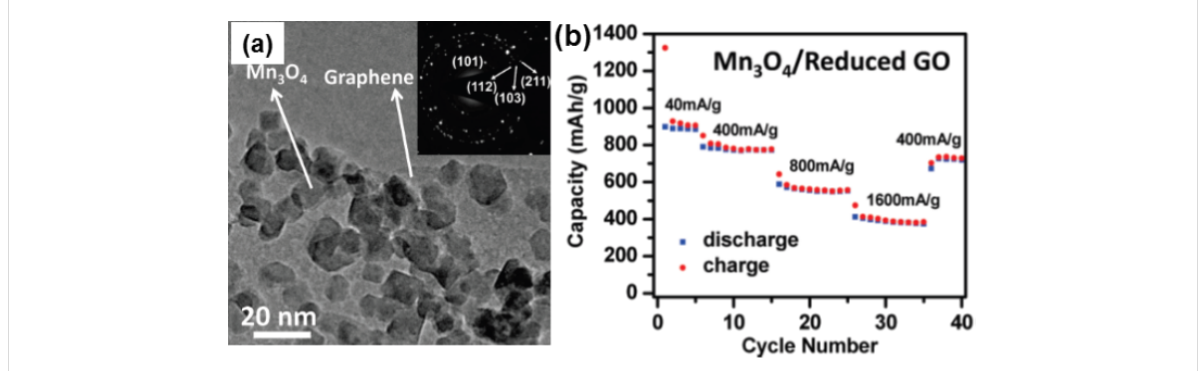
Figure 4: (a) TEM images of the Mn 3 O 4 –rGO hybrid; the inset shows the electron diffraction pattern of the Mn 3 O 4 NPs on rGO. (b) Capacity reten- tion of the Mn 3 O 4 –graphene-hybrid-based anode at various current densities. Reprinted (adapted) with permission from [136], copyright 2010 Amer- ican Chemical